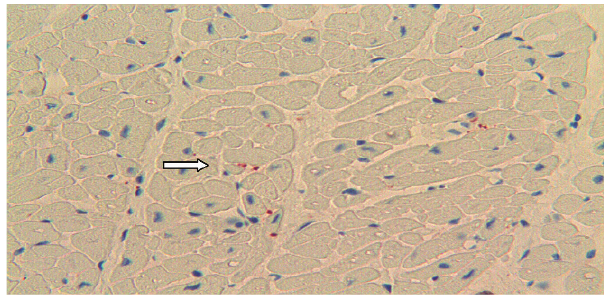
Figure 3 - S100B positivity in inter-myocytes spaces with accentuation of Schwann cells in a nerve twig X